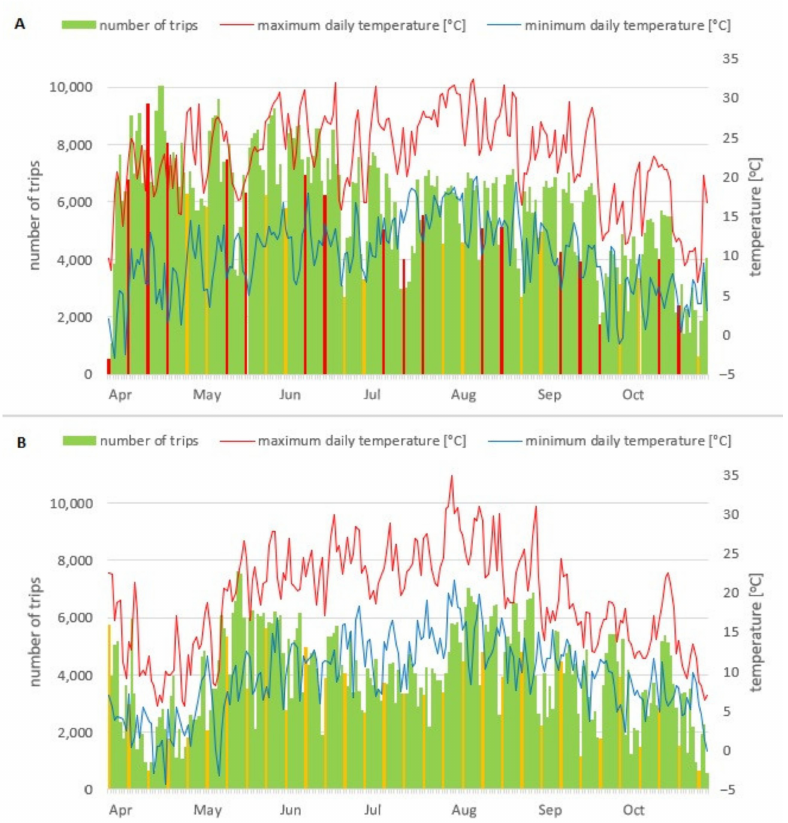
Figure 6. Daily number of ŁPB trips against differentiation of maximum and minimum daily temperatures in Ł ó d´z in 2017 ( A ) and 2018 ( B ); green bar–Mon–Fri, yellow bar–trading Sunday, red bar–non-trading Sunday. Source: own elaboration based on data from the Ł ó d´z City Hall and archival data of the Institute of Meteorology and Water Management at the National Research